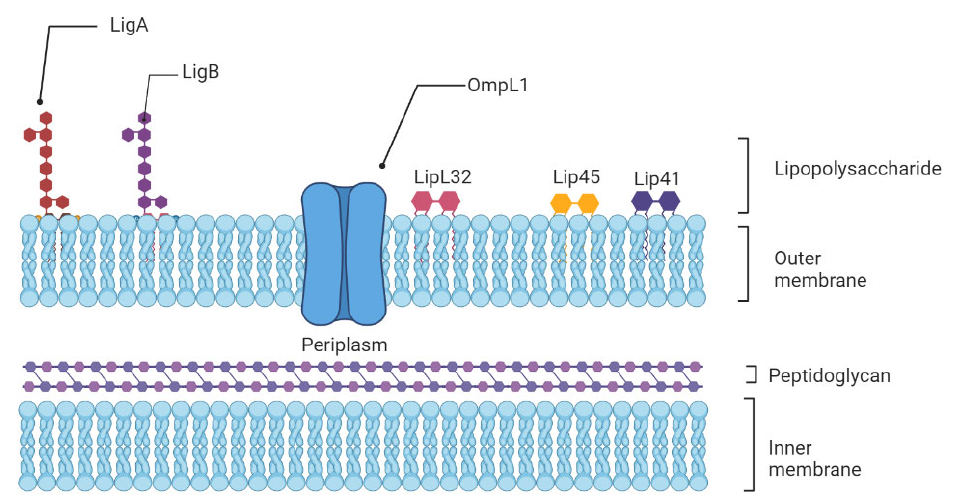
Figure 1. Schematic representation of the architecture of the leptospiral membrane. The inner membrane is closely associated with the peptidoglycan cell wall, which is overlaid by the outer membrane. Surface-exposed lipoproteins (LipL32, LigA, LigB), the transmembrane outer membrane protein porin L1 (OmpL1), and lipopolysaccharide are among the main components of the outer membrane.